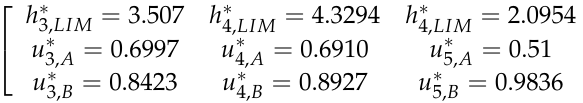
Table 11. Simulation results when the volume of overflow is minimized (strategy